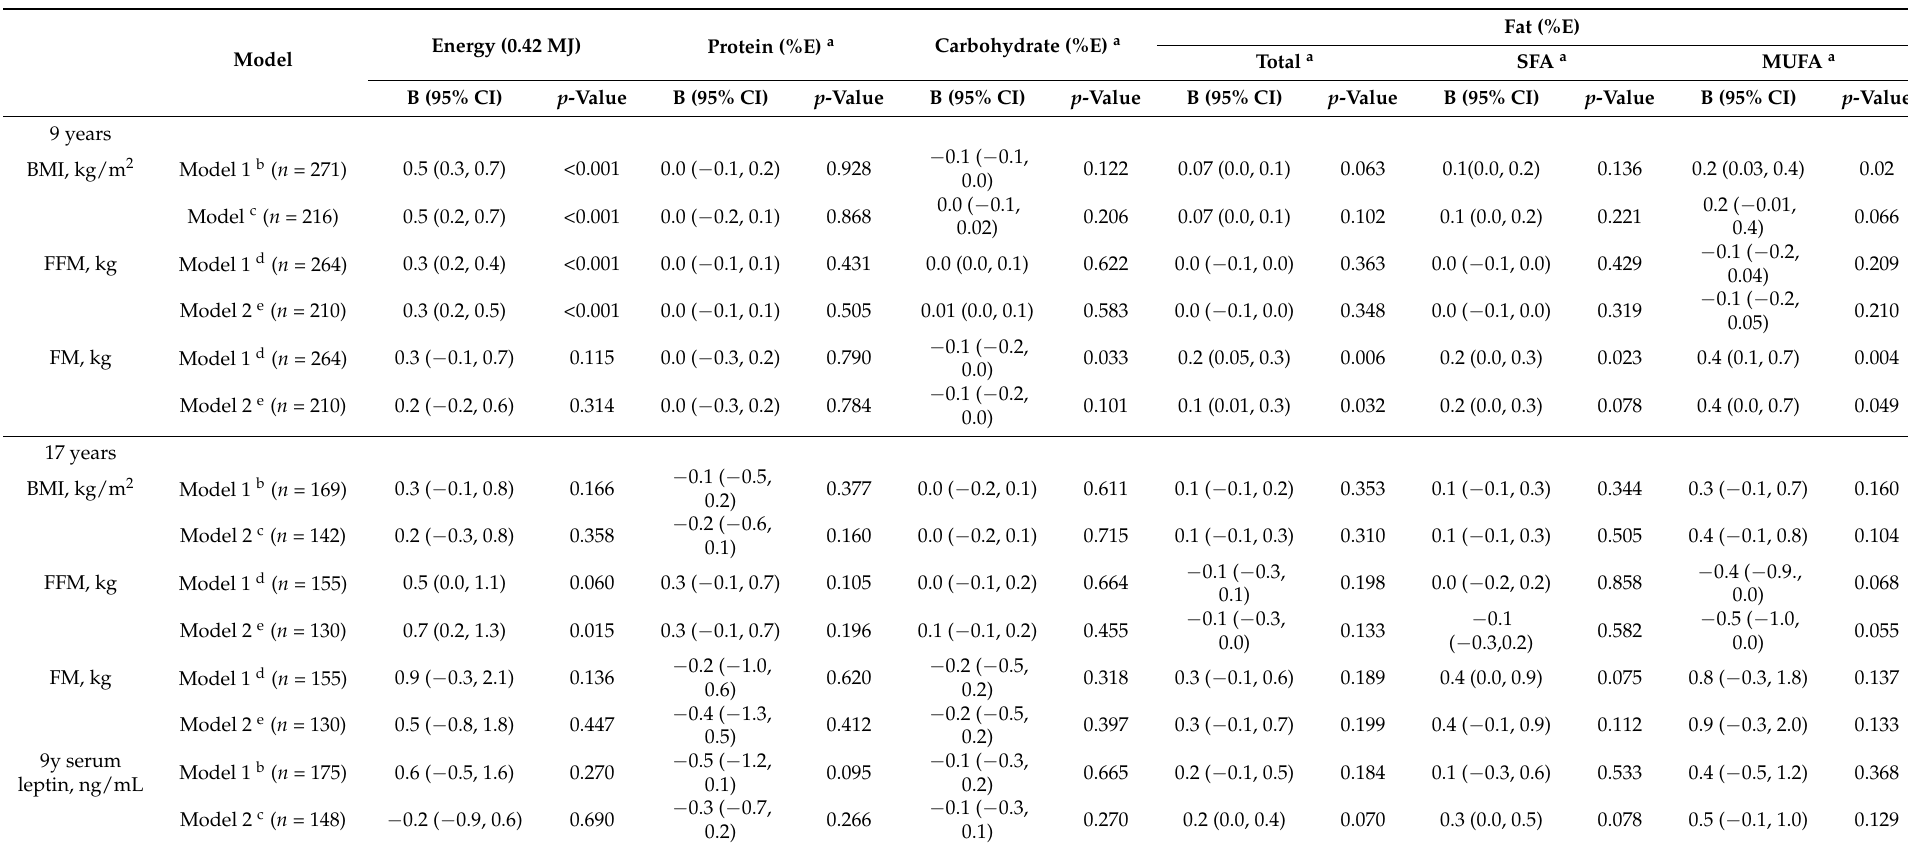
Table 3. Multiple linear regression models for energy and energy − adjusted macronutrient intakes of boys (plausible reporters only), using diet collected at 18 months of age to predict body composition, serum leptin concentration at 9 years of age and body composition at 17 years of age in children enrolled in ALSPAC −